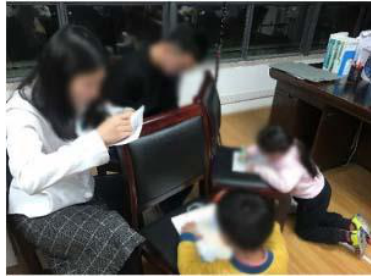
Figure 4. Two types of participants filling out